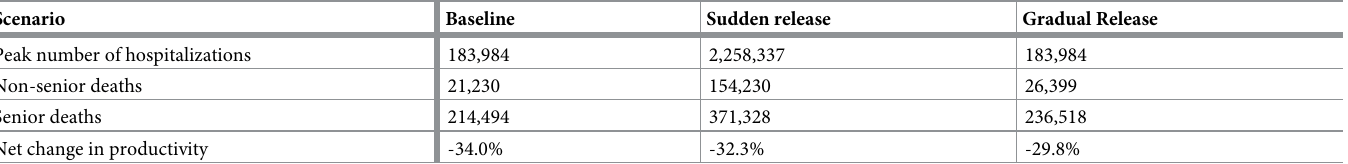
Table 2. Summary of predicted results from the different